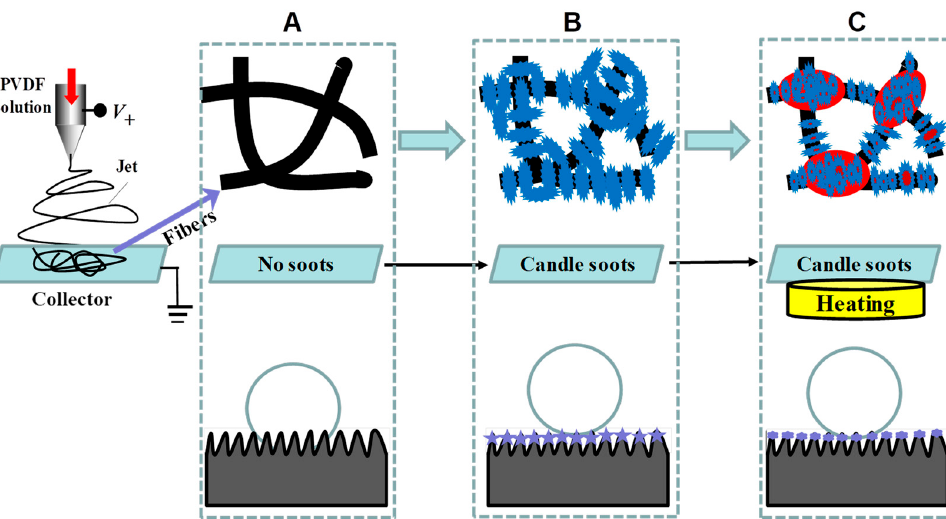
Figure 5. Schematic illustrating the resultant electrospun fibers and the corresponding wetting states: ( A ) smooth fibers collected on a conventional substrate without soot and Wenzel model for a wetting droplet, ( B ) fibers collected on an unheated substrate covered with candle soot and Cassie–Baxter model for a droplet, and ( C ) fibers collected on a heating substrate covered with candle soot and combined model for a droplet.